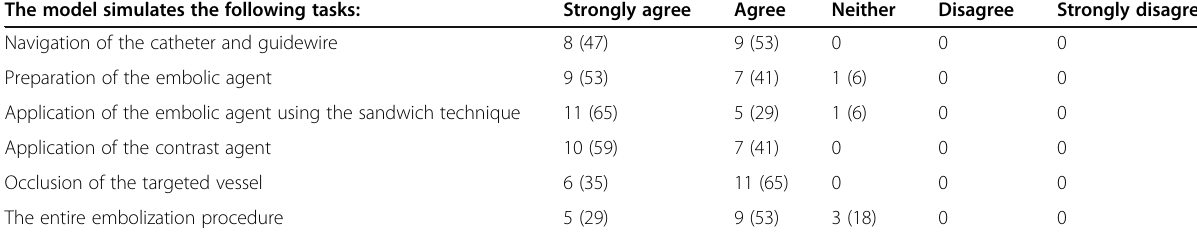
Table 1 Summarized answers of the participants to the questionnaire regarding the simulator ( n = 17) The model simulates the following tasks: